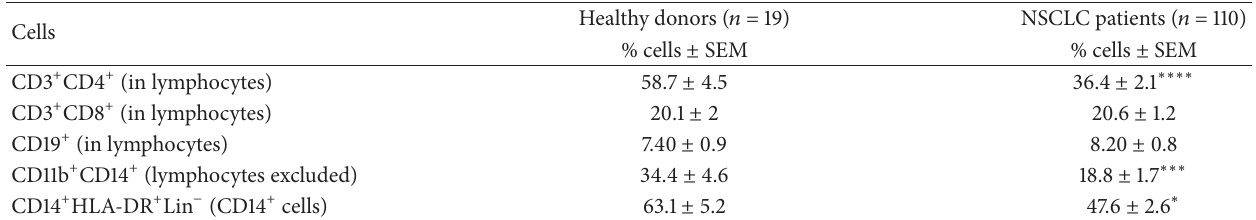
Table 3: T cells, B cells, DC/monocytes in the blood of NSCLC patients and healthy controls. Percentages of the cells in the peripheral blood of NSCLC patients and healthy controls as obtained by flow cytometry analysis. Percentages indicated in the plots represent the percentages of phenotypic marker expression in the parental population, which are presented in brackets. Data presented as Mean ± SEM of the. ( ∗,∗∗∗,∗∗∗∗ 𝑃 < 0.05, 0.001, 0.0001,